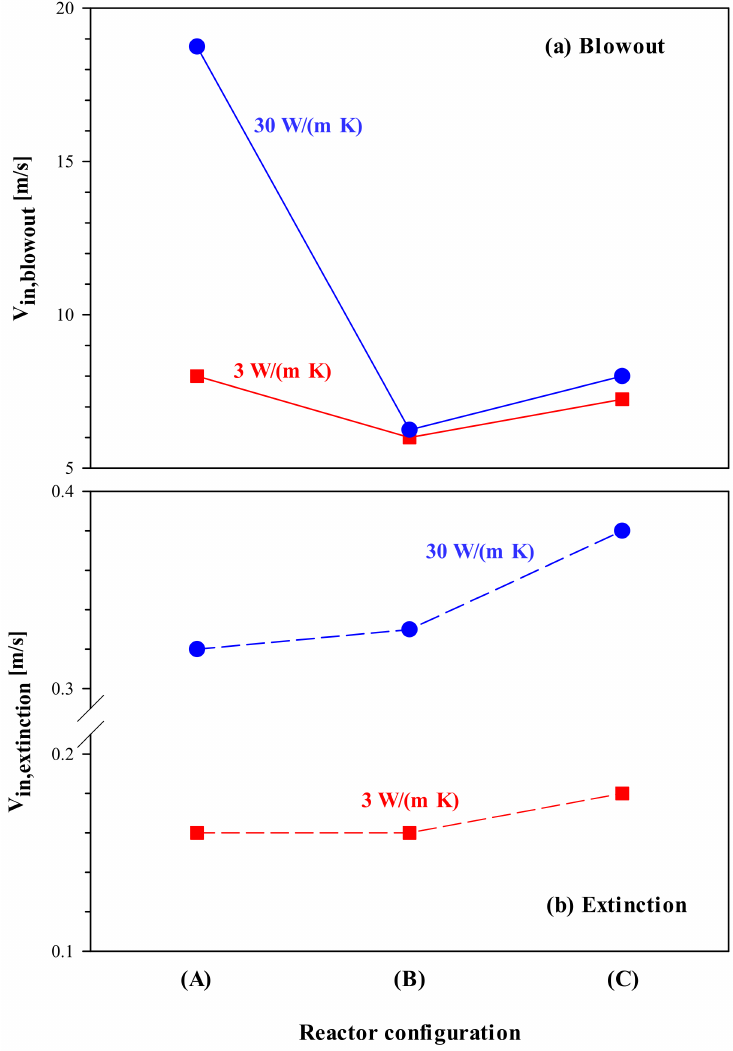
Figure 11. ( a ) V in,blowout and ( b ) V in,extinction for the three reactor configurations of Figure 1: (A) Both walls catalytic ; (B) Inner wall catalytic ; and (C) Outer wall catalytic. Low (3 W/(m K)) and high (30 W/(m K)) thermal